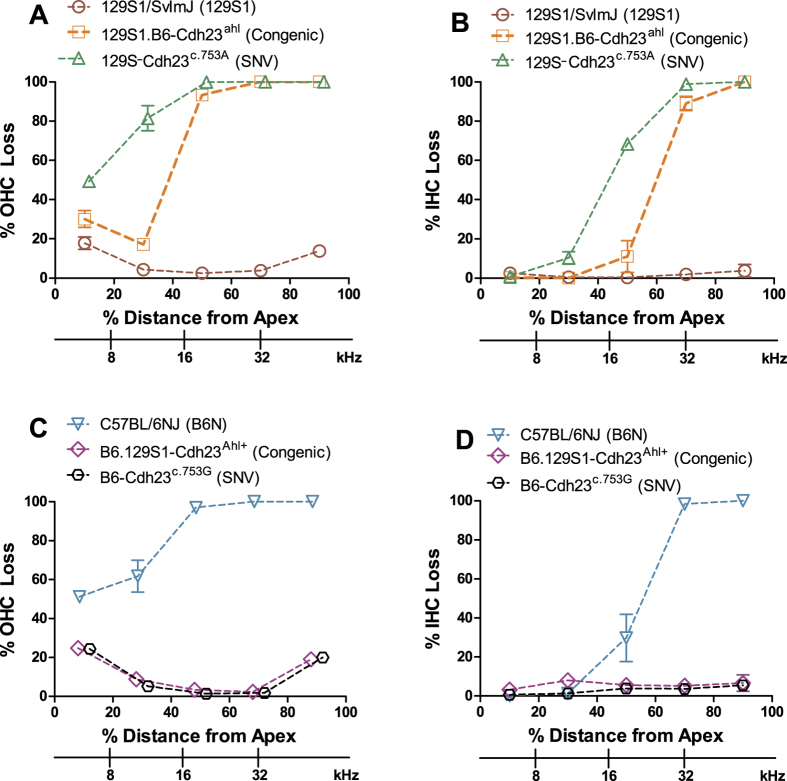
Cochlear hair cell loss associated with Cdh23c.753 variants.Cochleograms show the mean (+/−SEM, n = 4 cochlea per group) percent outer hair cell loss (OHC; A,C) and inner hair cell loss (IHC; B,D) in 20% intervals plotted as a function of percent distance from the apex of the cochlea. Cochlear locations related to frequency36 are shown on the x-axis. (A,B) Increased hair cell loss in 6-month-old 129S-Cdh23c.753A (SNV) and 9-month-old 129S1.B6-Cdh23ahl(Congenic) mice compared with 9-month-old 129S1/SvImJ (129S1) parental strain mice indicates a strong influence of the Cdh23c.753A allele in accelerating age-related hair cell degeneration. (C,D) Minimal hair cell loss in 18-month-old B6-Cdh23c.753G (SNV) and B6.129S1-Cdh23Ahl+ (Congenic) mice compared with age-matched C75BL/6 NJ (B6N) parental strain indicates a strong influence of the Cdh23c.753G allele in preventing age-related hair cell degeneration.